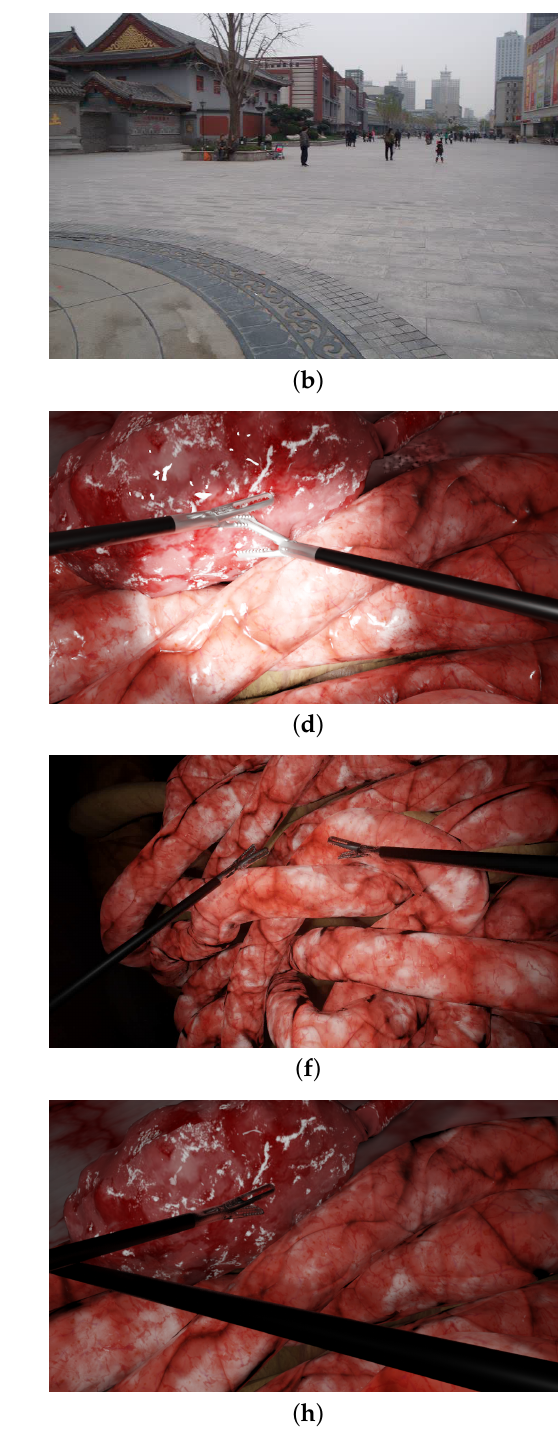
Figure 3. The scenarios used in the experiments. The left and right columns show the left and right images, respectively: ( a , b ) typical non-laparoscopic situation of a temple; ( c , d ) two tools with medium parallax; ( e , f ) two tools with high parallax; ( g , h ) two intersecting